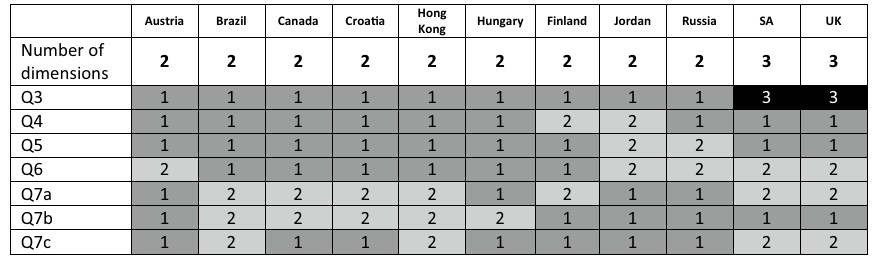
Table 9 Results of the multiple correspondence